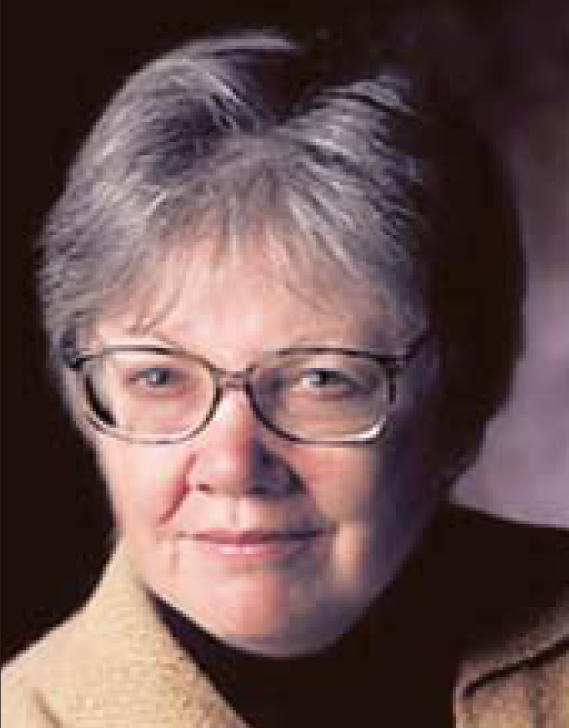
Ellen K. Silbergeld